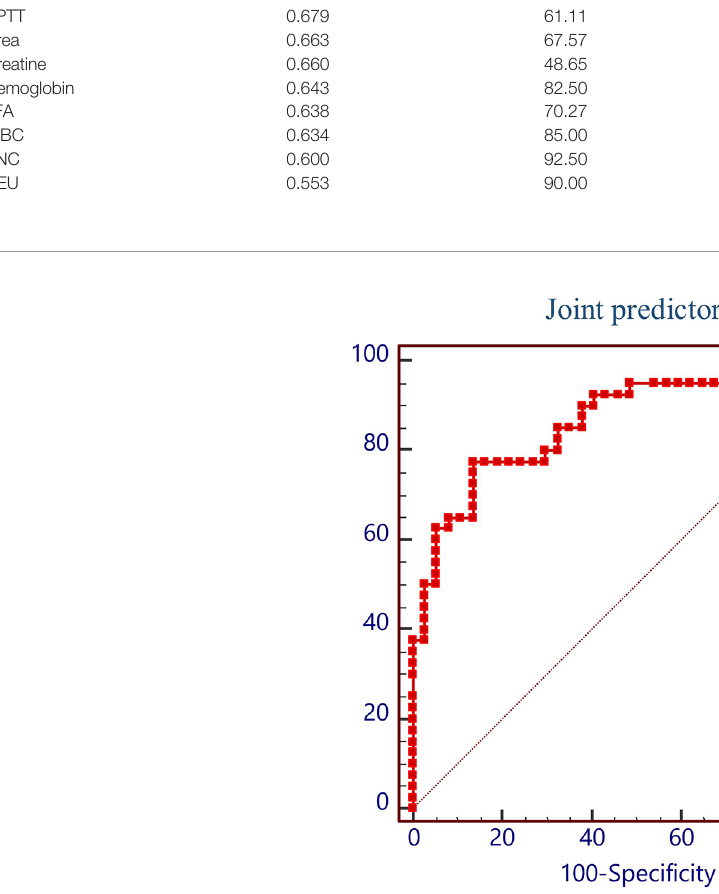
FIGURE 2 | ROC curve of joint